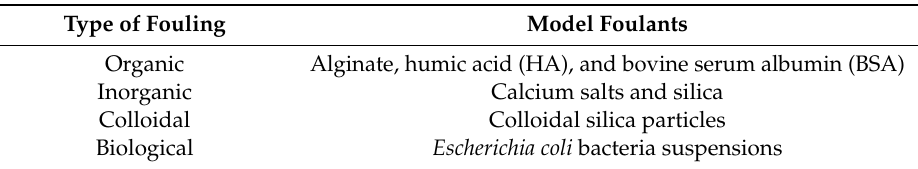
Table 4. Fouling types and model